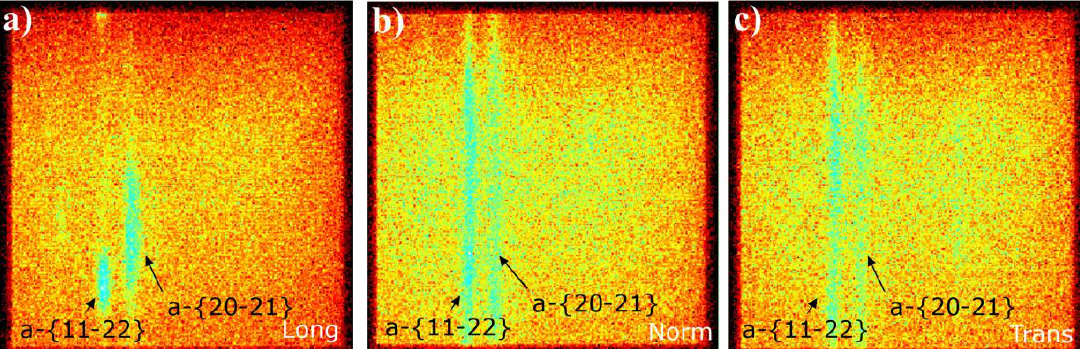
Figure 7. Image of 2D detector obtained during neutron diffraction experiment on the WAAM part (at 46 mm) for ( a ) longitudinal direction, ( b ) normal direction, ( c ) transversal direction. Note: the images are normalized to the maximum intensity, the pixel size is 1.17 mm × 1.17 mm.